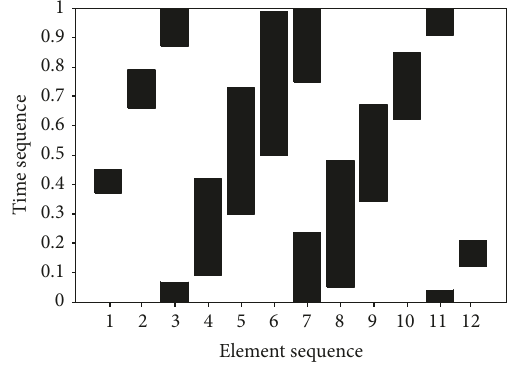
Figure 8: Time sequences of elements.